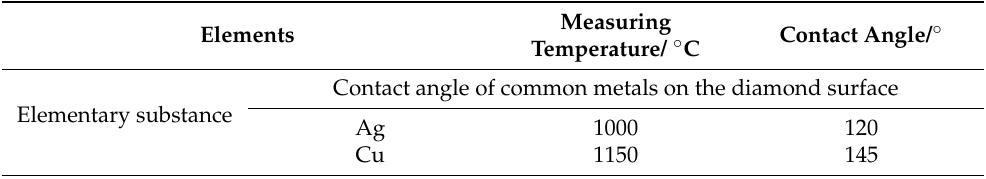
Wetting angle of the alloys containing active elements on the